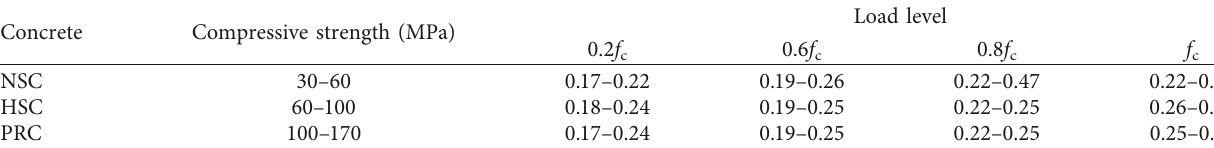
Table 3: The lateral deformation coefficient of concrete with different strengths.